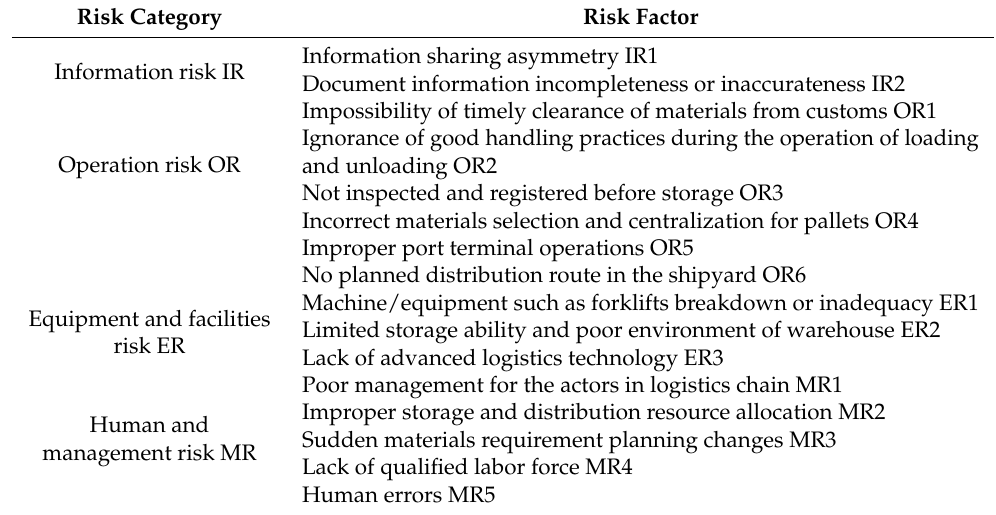
Table 1. Risk factors list for